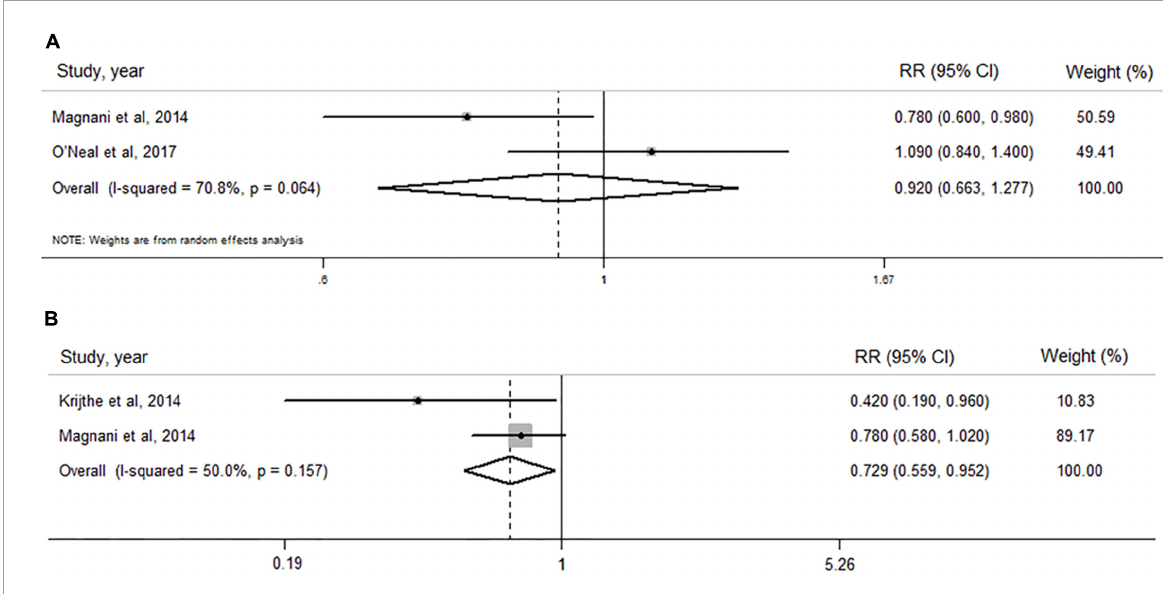
FIGURE3 Forest plots of the association between levels of estradiol and dehydroepiandrosterone sulfate and risk of atrial fibrillation by pooling cohort studies. (A) The random-effect model was used to assess the association of estradiol level with atrial fibrillation risk in men; (B) the fixed-effect model was used to assess the association of dehydroepiandrosterone sulfate level with atrial fibrillation risk in